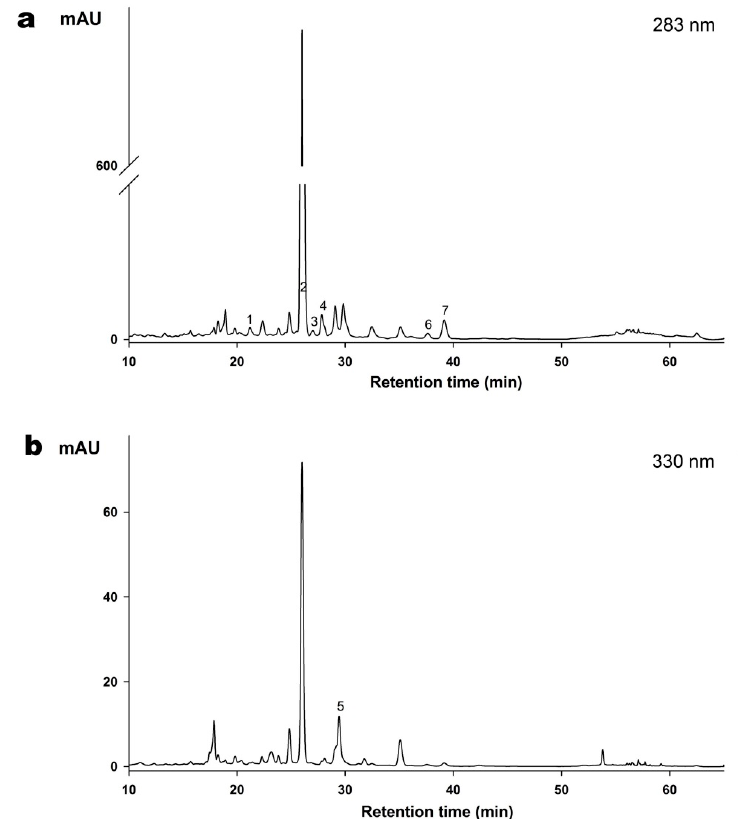
Figure 2. High performance liquid chromatography (HPLC) analysis with detection at 283 nm ( a ) and 330 nm ( b ) of the ZQE. Samples were analyzed using 15–75% methanol in 0.3% formic acid for 70 min.